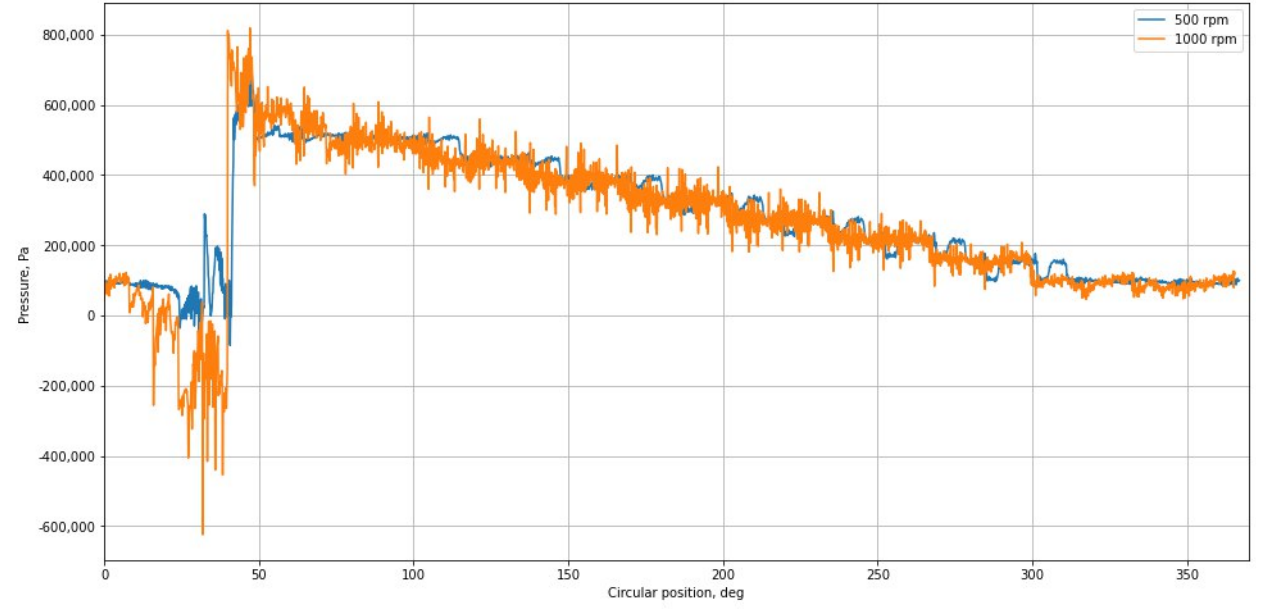
Figure 11. Pressure changes in circumferential direction for 500 rpm and 1000 rpm. Table 2. Simulation model parameters for the fuel